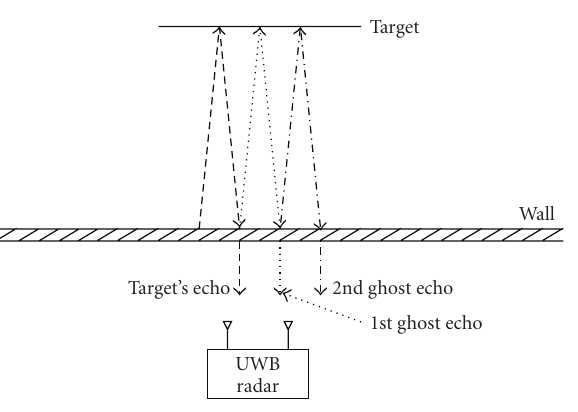
Figure 23: Construction of ghost